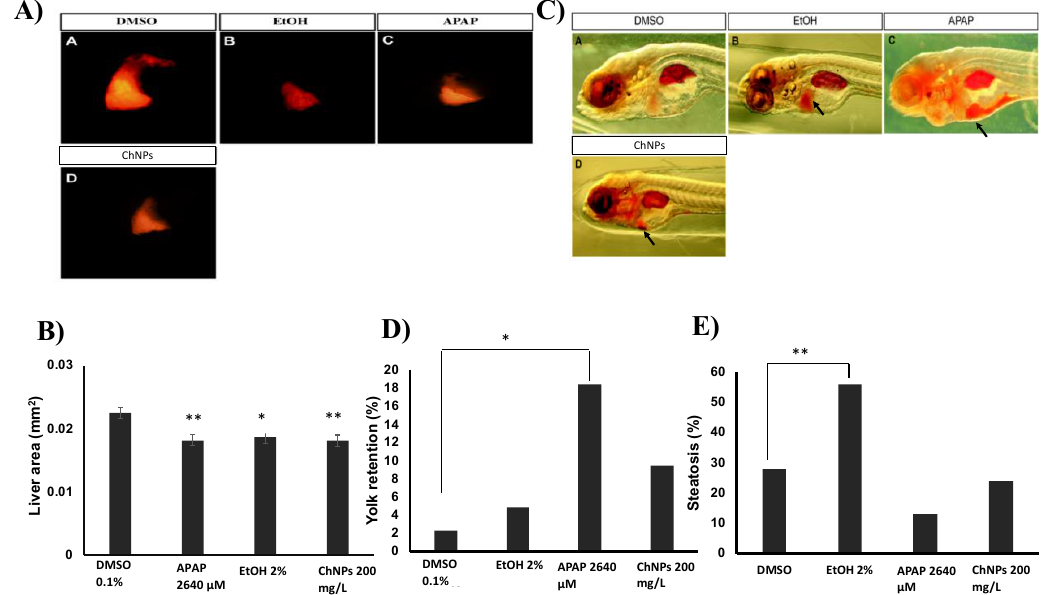
Figure 6. ( A ) Representative images for the RFP liver area after each treatment. ( B ) Quantification and measurement of the RFP liver area (mm 2 ) for the controls and all the tested compounds. ( C ) Representative images for steatosis and yolk retention. Arrow ( ) in EtOH treatment indicate liver steatosis (absorbed ORO stain by the liver), and arrows ( ) in paracetamol (APAP) and ChNP treatments indicate increased yolk retention (absorbed ORO stain by the yolk). ( D ) Percentages of embryos showed yolk retention and (E ) steatosis. Thirty embryos were used for each treatment in every experiment. *, significantly different from DMSO ( p < 0.05); **, significantly different from DMSO ( p < 0.01).